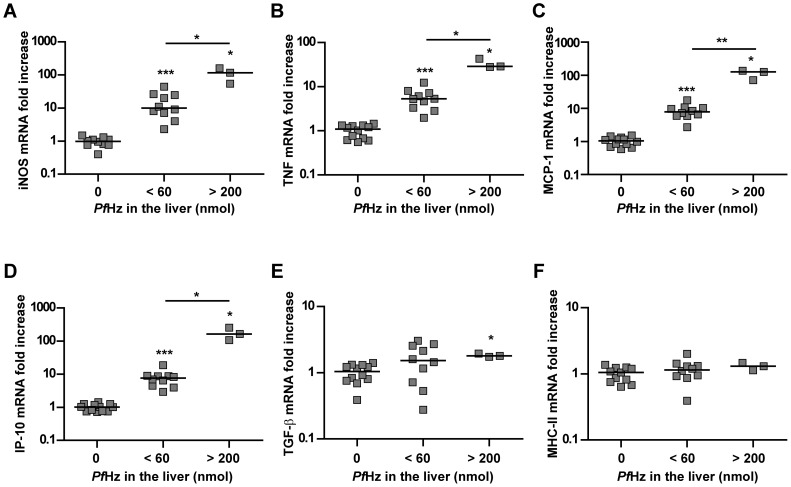
Injection of PfHz induces the expression of inflammatory mediators in the liver.Naive malaria-free C57BL/6J mice were injected intravenously with different amounts of PfHz and dissected 6 hours later. Hepatic mRNA expression levels are shown for iNOS (A), TNF (B), MCP-1 (C), IP-10 (D), TGF-β (E) or MHC class II (F) as determined by quantitative RT-PCR and normalized to 18S ribosomal RNA levels. Data for other mediators are shown in table 3. Data were stratified according to the total amount of PfHz measured in the liver. Horizontal bars between individual data points indicate group medians. Horizontal lines with asterisks on top indicate statistical differences between groups. Asterisks above individual data sets indicate statistical differences with the vehicle-injected control group. * p<0.05, ** p<0.01 and *** p<0.001.